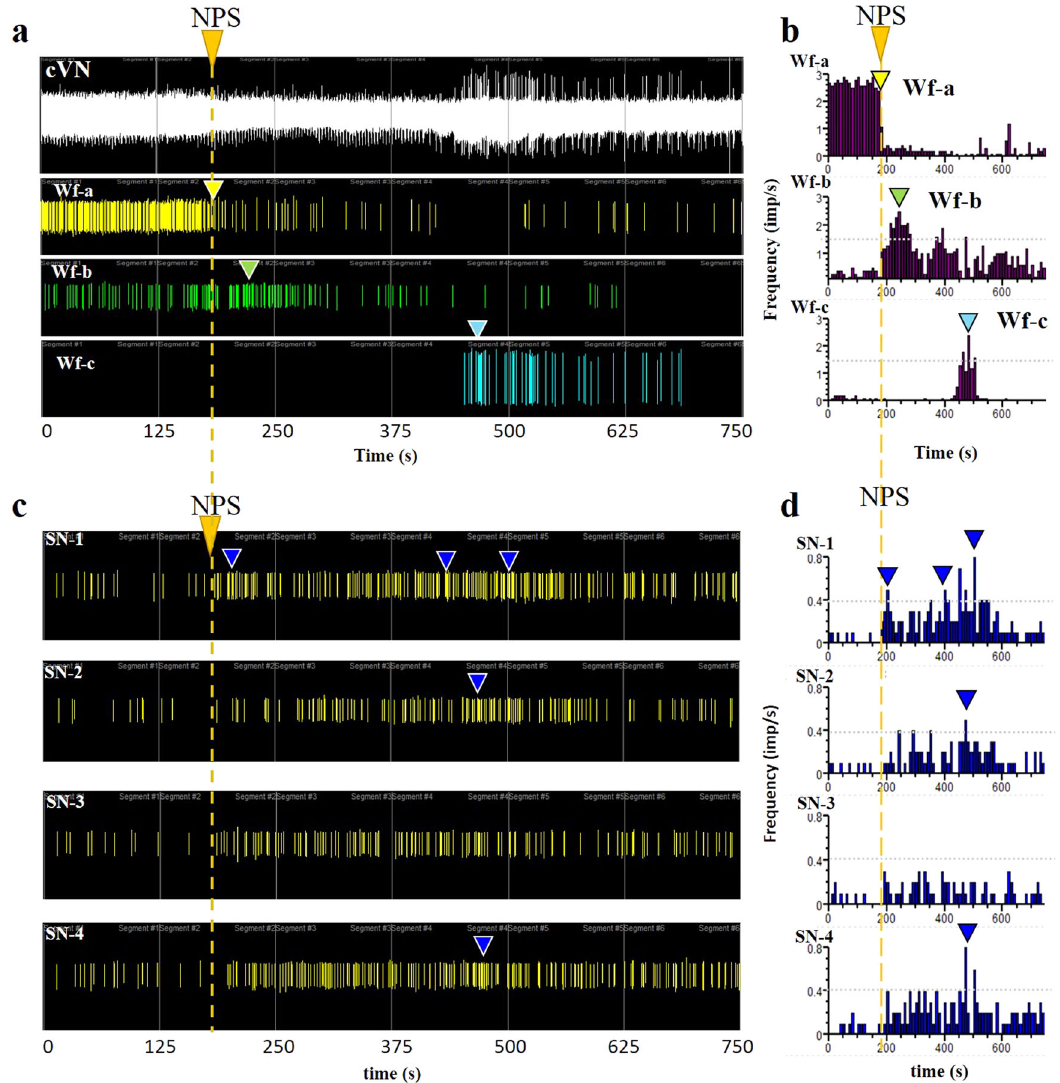
Fig. 5 Hypotension inhibits cVN activity, followed by differential splenic branch activity. a NPS administration (orange arrow and dashed line) causes a reduction in cVN activity (Wf-a, yellow arrow), and activation of two separate Wf (Wf-a and b, green and blue arrows, respectively), as demonstrated by the frequency histograms ( b ), changes in amplitude of the signal at 200 s compared to baseline was 1.6 ± 1.02 µ V (Supplementary Fig. 4). c Simultaneous recording of neural activity in the four splenic branches showed a differential temporal response in frequency fi ring, with SN-1 following the loss of cVN Wfa, and SN-2 and SN-4 activated simultaneously with VN Wf-c. Delta in amplitude in response to the drop in mean arterial pressure (baseline vs. 200 s after NPS administration) where 4.6 ± 1.3, 3.4 ± 1.9, 0.9 ± 0.8, 2.8 ± 1.2, for SN-1 – 4, respectively. Tukey ’ s multiple comparisons tests showed SN-1 vs. SN-3 ** P = 0.006, alpha = 0.05, n = 5 (Supplementary Fig. 4). d Frequency histograms show speci fi c time of increased activity over a 40% threshold (blue arrowheads in c and d ). Representative waveforms were observed from n = 6 animals. NPS nitroprusside, cVN cervical vagus nerve, Wf waveform, SN splenic (Fig. 8h, h´´). Negative controls (where SNVP was transected after viral administration, (Supplementary Fig. 8) did not present signal as expected (Fig. 8d´ and Supplementary Fig. 9f). Together, the data indicate that the brain has a direct anatomical and functional connection with the spleen through the VN, not previously recognized (Fig. 9).